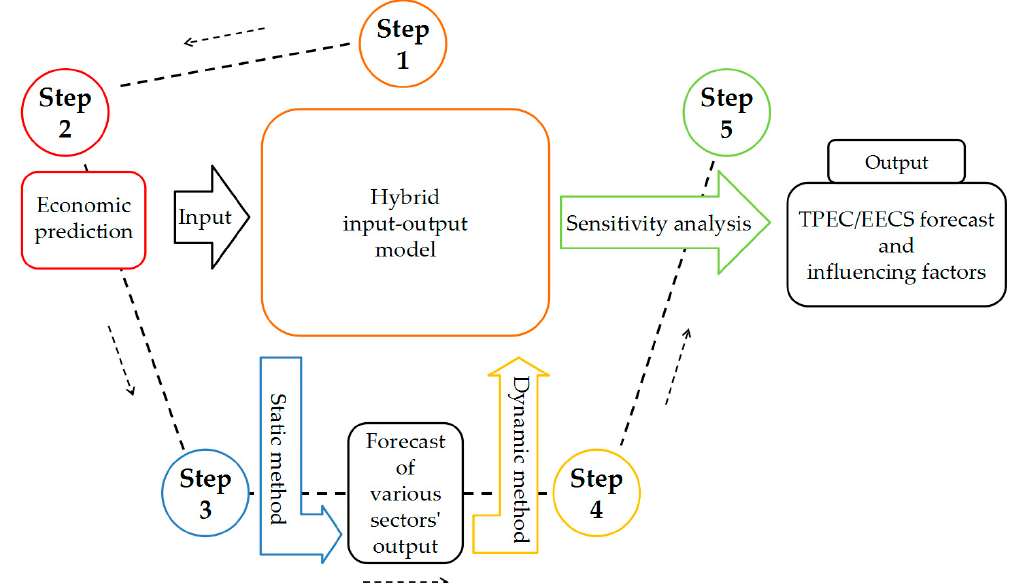
Figure 1. The combination of static and dynamic hybrid input-output (CSDHI/O)